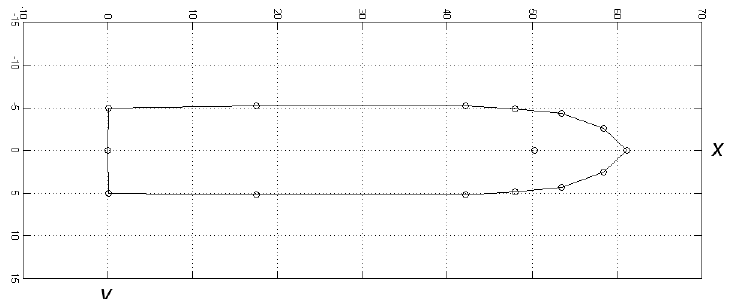
Figure 5. Model vessel’s contour consisting of 14 points in the body-fixed reference metric frame and GNSS antenna’s position in the fore part .